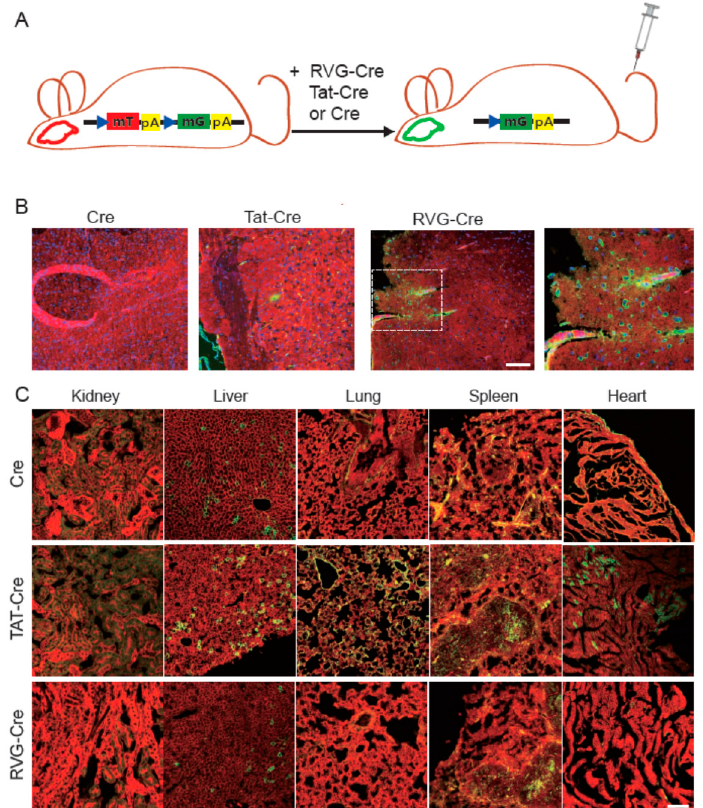
Figure 2. RVG-Cre mediates efficient recombination in the brain after tail vein injection. ( A ) Schematic showing the fluorescence switching principle of the mTmG Cre reporter mouse line. RVG-Cre, Tat-Cre, Cre were administered systemically through tail vein injection on three consecutive days. GFP is shown in green and tdTomato is shown in red; ( B ) Brain sections of wt Cre, Tat-Cre and RVG-Cre injected into mTmG mice. Enlarged view of the dashed box is shown; ( C ) Fluorescence microscopy of other tissues from wt Cre, Tat-Cre and RVG-Cre injected mTmG mice ( n = 3). Scale bar is 200 µM.